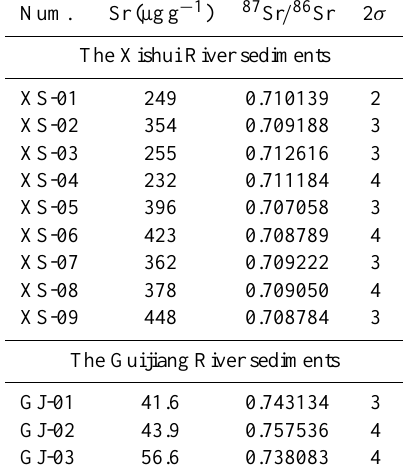
Table 3. Sr isotopic compositions of the Xishui River and Guijiang River riverbed sediments and soils. Num.